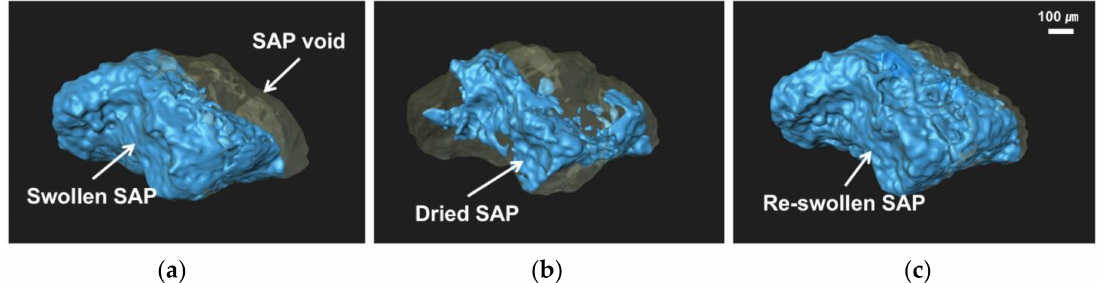
Figure 9. Three-dimensional images of SAP particles and voids in a crack surface of an S-0.5 specimen: ( a ) after cracking; ( b ) after a drying cycle; ( c ) after a wetting